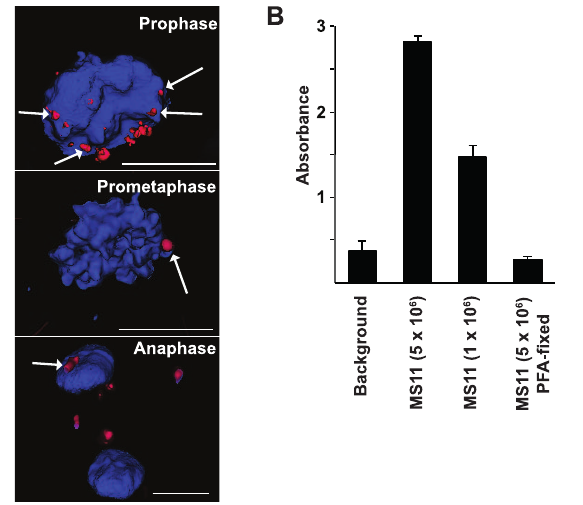
Figure 4. Subcellular location of intracellular bacteria in mitosis. A. VK2/E6E7 cells were infected with DyLight 594 NHS Ester-stained N. gonorrhoeae . Cells were maintained in a live-cell incubator connected to an inverted fluorescence microscope. Cellular DNA was stained with Hoechst 33342 and is shown in blue. Images of live mitotic cells were taken through a 100x oil objective in 40–60 z-stacks. Images were further deconvolved and processed by Inside 4D software. Bacteria (red) present during prophase (upper), prometaphase (mid) and anaphase (lower) are shown. Bacteria that are in close proximity to the chromatin are marked with arrows. The scale bar represents 10 m m. B. Viable bacteria associate with chromatin in ELISA. Chromatin, extracted from 1.25 6 10 5 cells was coated in each well. Viable (5 6 10 6 CFU/well or 1 6 10 6 CFU/well) or PFA-fixed (5 6 10 6 CFU/well) MS11P + was allowed to interact with the chromatin for 2 h at 37 ˚ C and 5% CO 2 . Rabbit anti- N. gonorrhoeae antibodies followed by goat anti rabbit IgG-HRP antibodies were used to detect the bacteria bound to the chromatin. Absorbance was read at 450 nm. Background was measured in wells containing all agents except chromatin. Shown is a graph of one assay in technical triplicate and standard